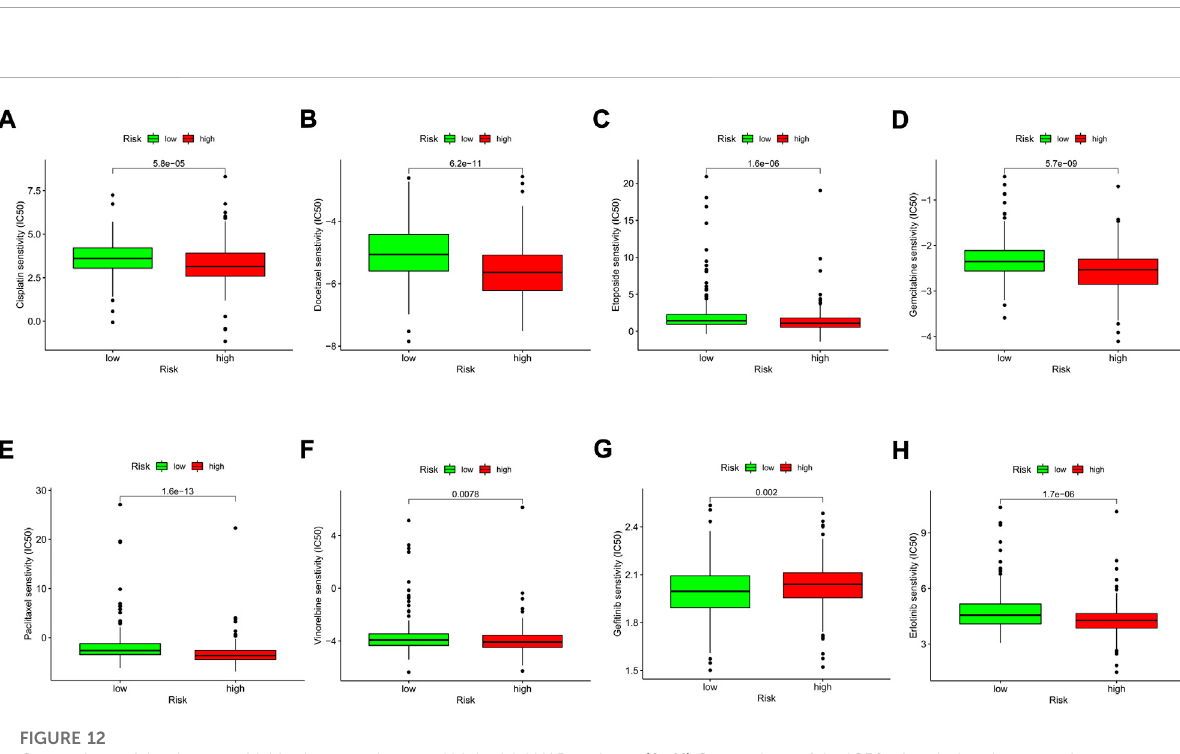
Frontiers in Cell and Developmental